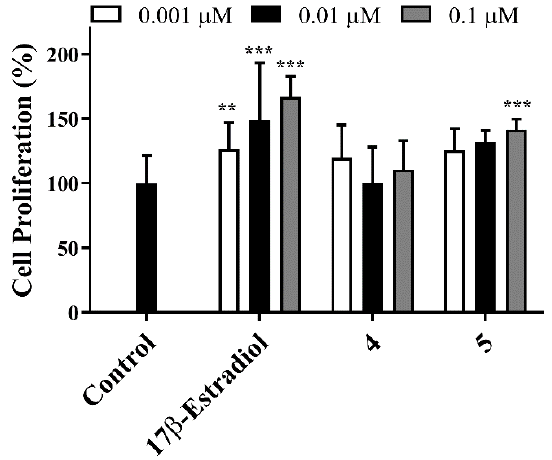
Figure 3. E-screening assay of compounds 4 and 5 in T-47D cells. Each bar represents the mean ± SD (two independent experiments). ** p < 0.01 vs. control; *** p < 0.001 vs. control (one-way ANOVA post-hoc Bonferroni test).